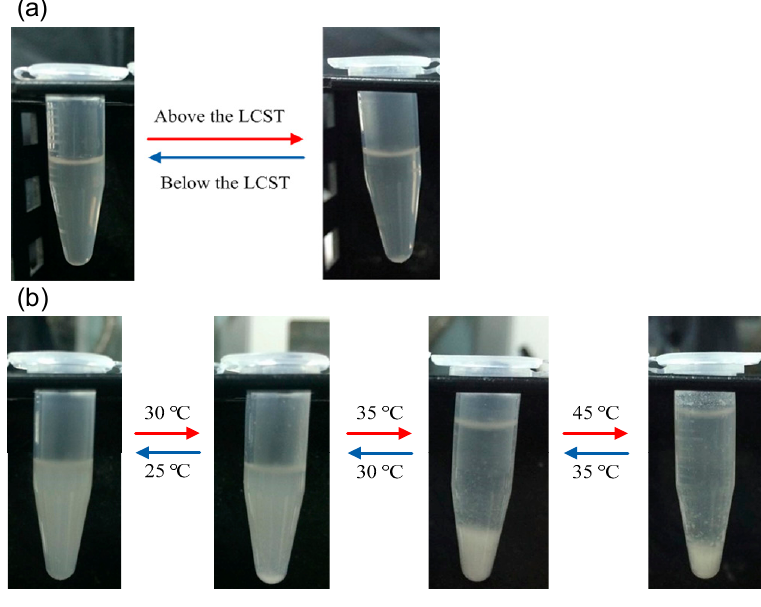
Figure 7. Illustrative images of ( a ) bare silica microspheres and ( b ) SPMs upon increasing the temperature above the LCST in aqueous solution.